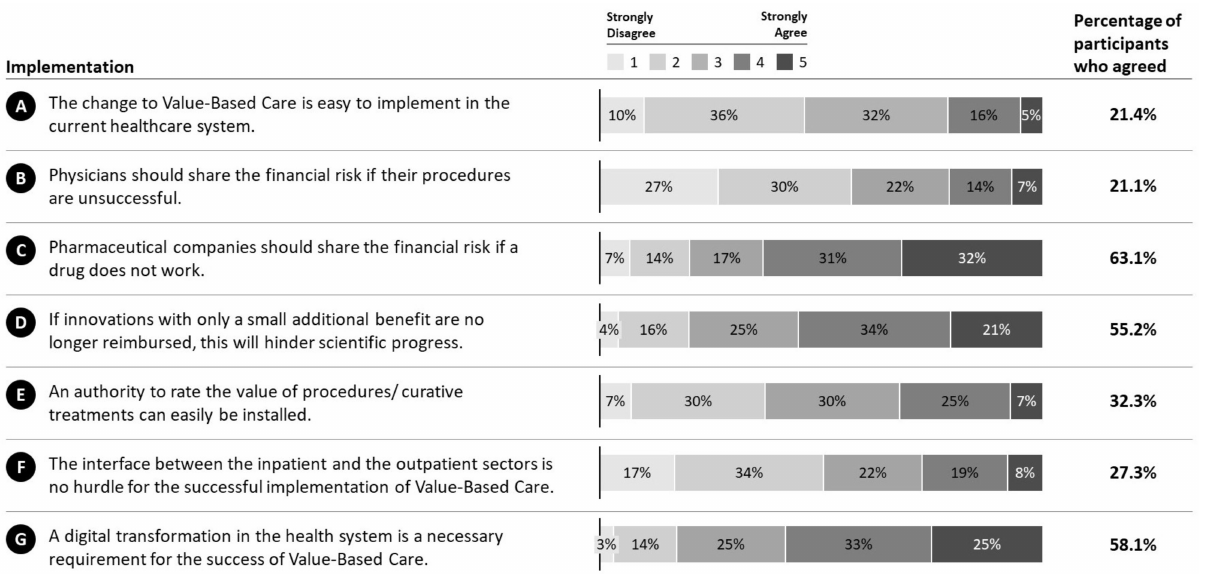
Figure 7. Implementation of VBC. Responses of participants regarding the further implementation of VBC in Germany. A : Ease of VBC implementation. B : Financial risk sharing of physicians. C : Financial risk sharing of pharmaceutical companies. D : VBC impact on scientific progress. E : Installation of an authority to rate value. F : Impact of interface of in- and outpatient sectors on VBC implementation. G : Necessity of digital transformation for VBC